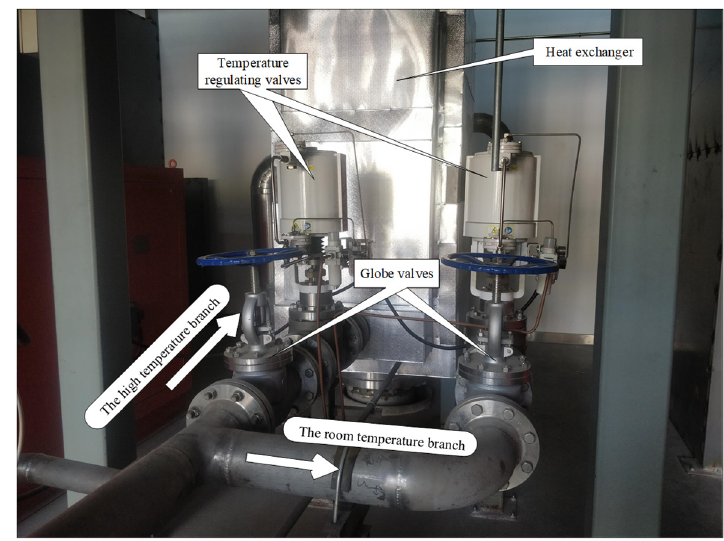
Figure 7. The temperature simulation unit components.